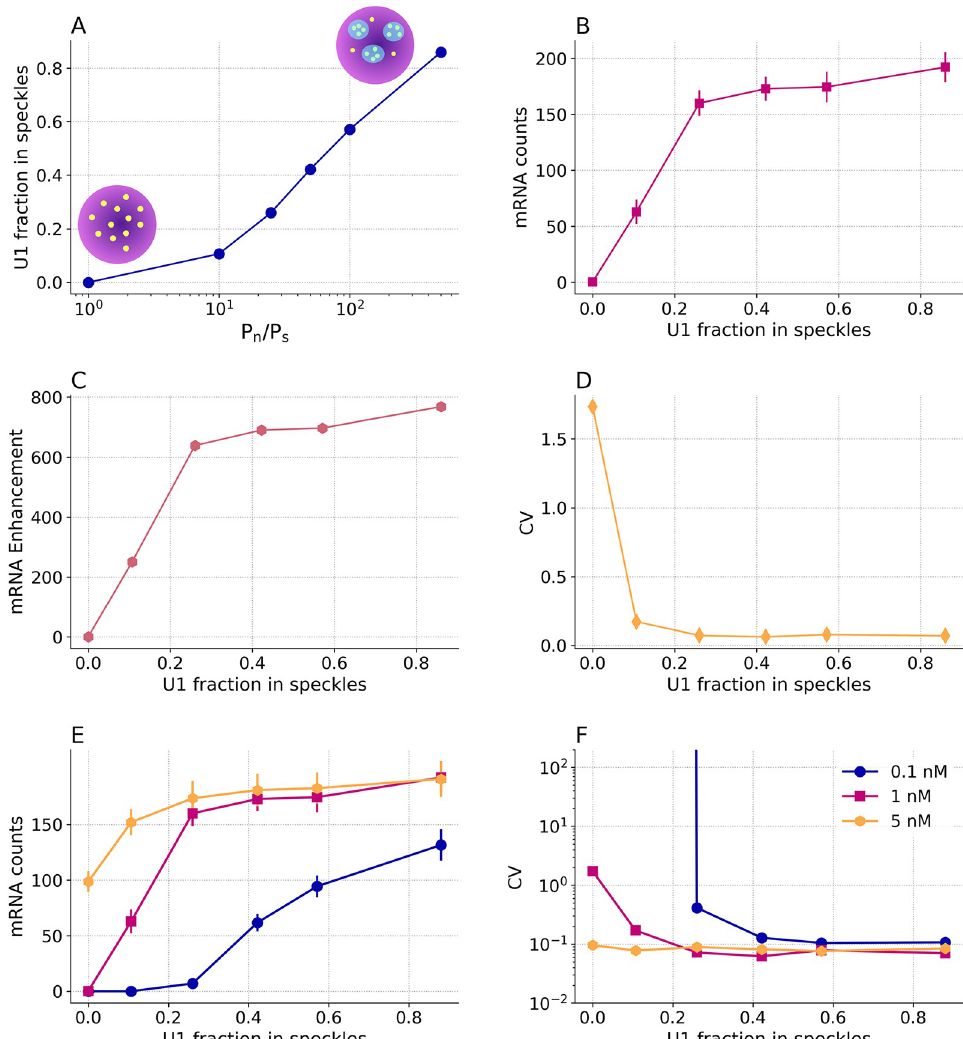
Fig 4. Splicing efficiency increases in the presence of speckles in the cells: A) The higher the probability for the splicing particles to transition from the cell nucleus to the speckles, relative to the reverse transition, the higher the localization of splicing particles in speckles. Schematically, the randomly distributed splicing particles (yellow dots) in the cell nucleus (colored in purple), localize in nucleus speckles (blue shaded regions) as the probability imbalance increases (the splicing particles concentration is 1 nM). B) As the percentage of splicing particles located in speckles increases, the number of spliced mRNA also increases. C) This enhancement in mRNA production is highly sensitive to the localization of splicing particles in speckles; with only a 10% localization of splicing particles in speckles, the splicing reaction is enhanced * 250-fold relative to the case with no speckles. D) Noise estimated as coefficient of variation (CV), decreases as a greater percentage of splicing particles are localized in speckles. Splicing particle concentration affects the functional advantage of speckles: E) Enhancement in mRNA production due to the presence of speckles, depends on the U1 splicing particle concentration; F) Effect of the U1 splicing particle concentration on the mRNA production noise. Note that for cells with 0.1 nM U1, below 25% splicing particle localization, the CV is not defined due to lack of mRNA production. For each condition, 20 simulation replicates were performed. For simulation details see